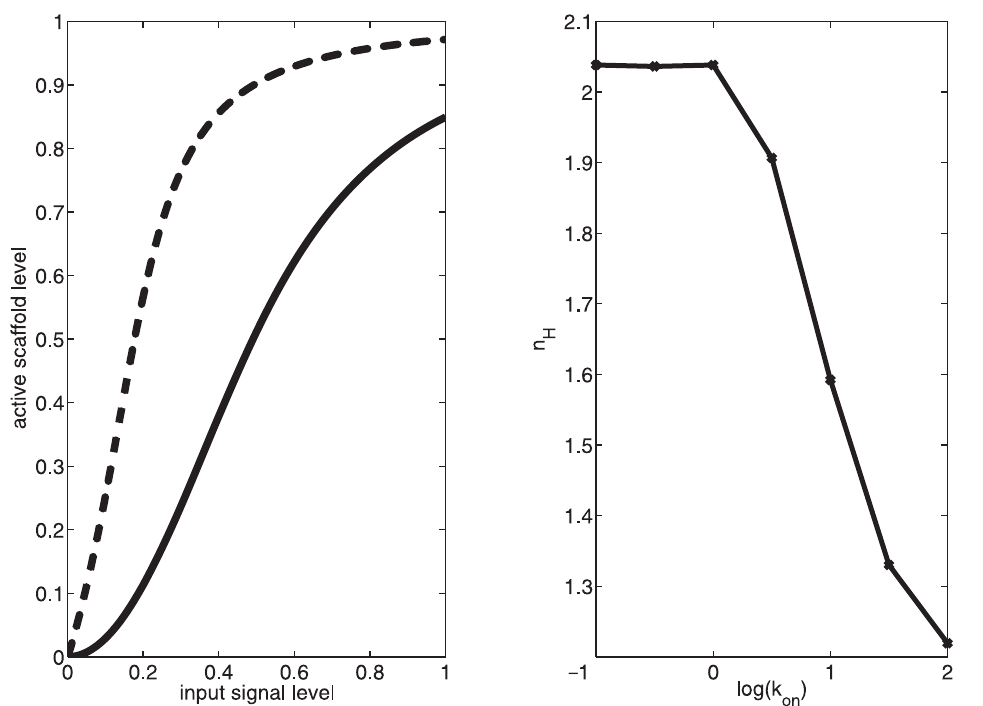
Figure 7. Signal response of the scaffold-MAPK complex as a function of scaffold-membrane binding and alignment rate. (left) Representative Hill plots for k on ~ 100 (dashed) and k on ~ 0 : 1 (solid). (right) Dependence of the Hill coefficient on k on . All other parameters as in table 4.